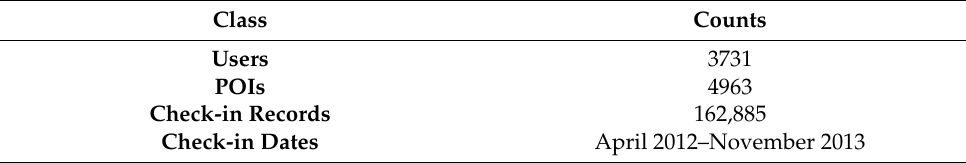
Table 1. Statistics of the